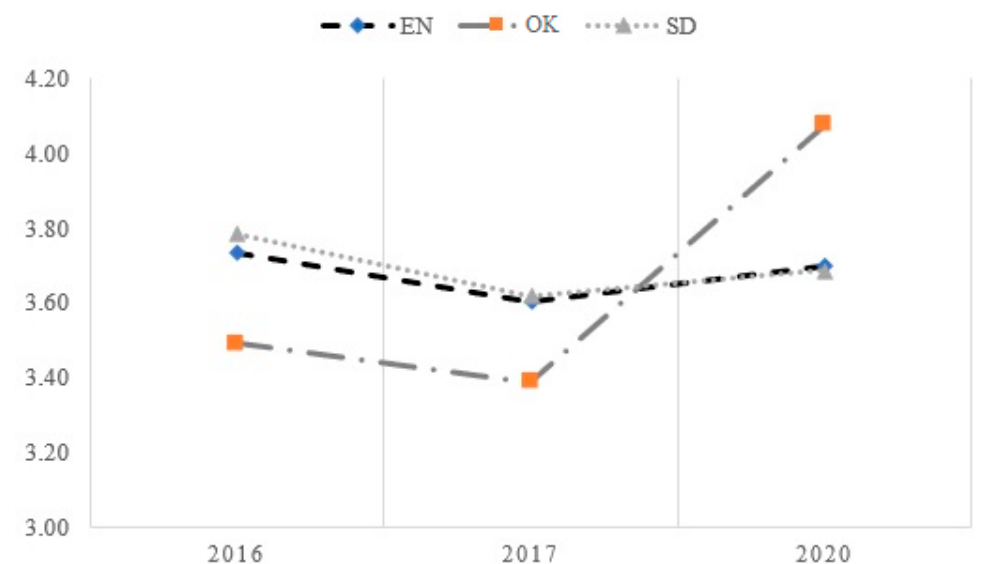
Figure 1. Variation in teacher perceptions at different points in time. EN—experience networks; OK—Olympic knowledge; SD—skills development.